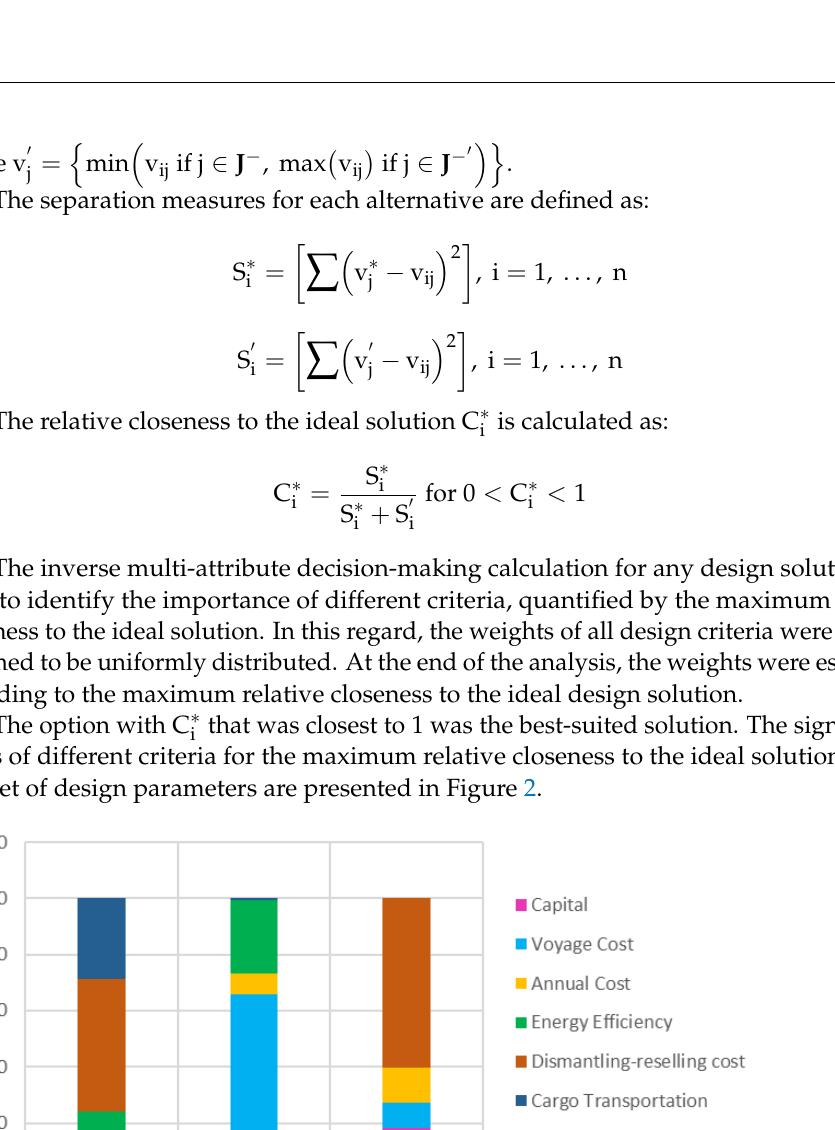
Figure 3. Significance of design criteria for energy consumption and carbon footprint.